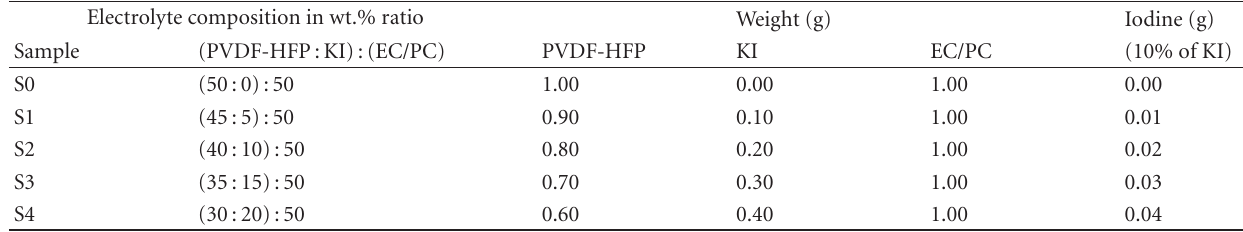
Table 1: Di ff erent compositions of PVDF-HFP polymer electrolyte. Electrolyte composition in wt.%